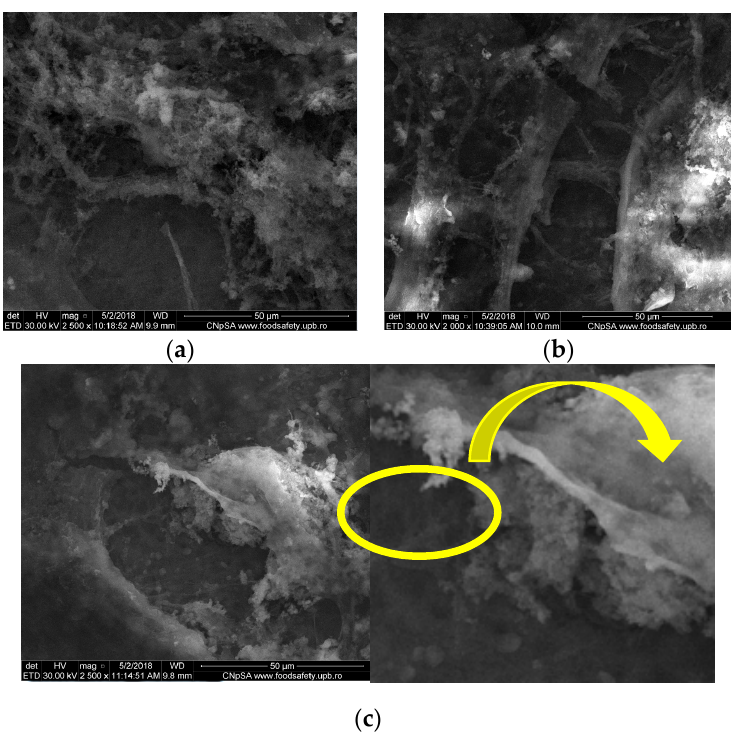
Figure 5. Scanning electron microscopy (SEM) images of Coll/CaPs thin films deposited by spin coating with different Zn(II) fractions ( a ) 0 wt%; ( b ) 1 wt%; ( c ) 2 wt%.